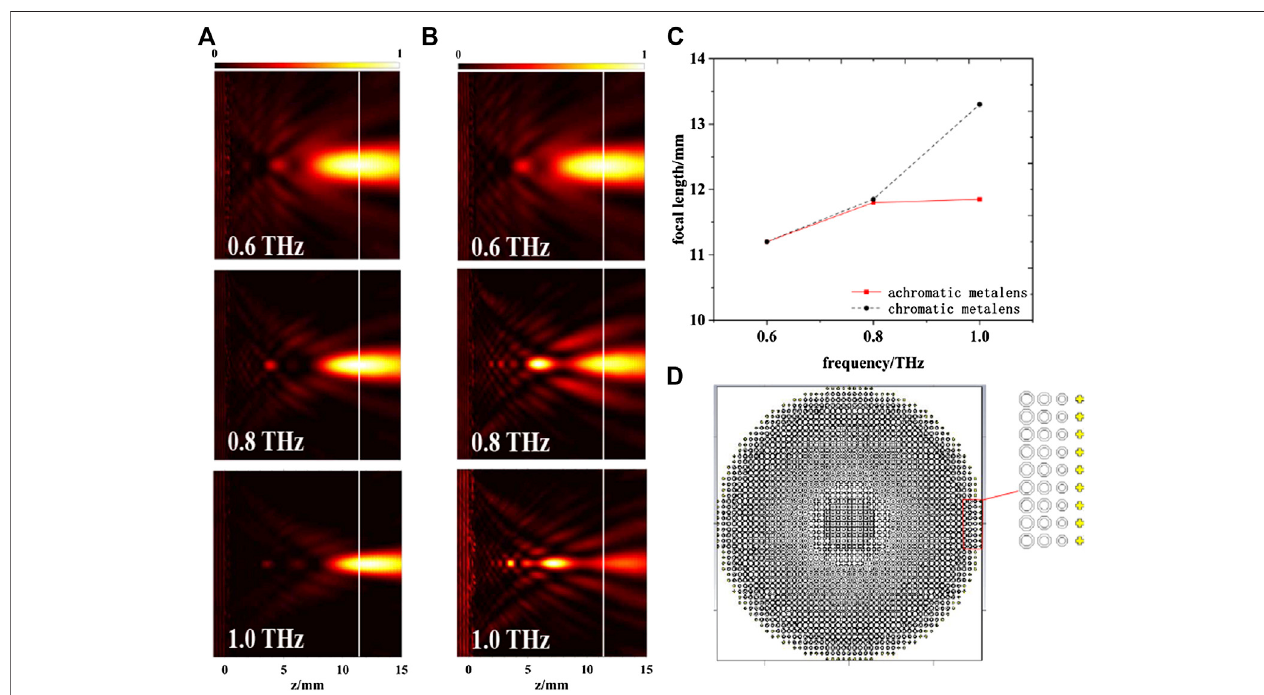
FIGURE 4 | The simulated results of the focusing performance of the achromatic meta-lens and the chromatic counterpart. (A) The electric fi eld intensity of the achromatic meta-lens in the x (cid:2) 0 plane for the normal incidence at 0.6, 0.8, and 1.0 THz, respectively. (B) The electric fi eld intensity of the chromatic counterpart in the x (cid:2) 0planeforthenormalincidence at0.6,0.8, and1.0 THz, respectively. (C) Theevolutionofthefocallengthasfrequencychanges.Theredcurverepresentsthefocal lengthevolutionofthe achromaticmeta-lens, and theblack curve represents that ofthecounterpart. (D) The sketch oftheachromatic meta-lens. The picture inset enlarges part of the structures used to form the metalens.